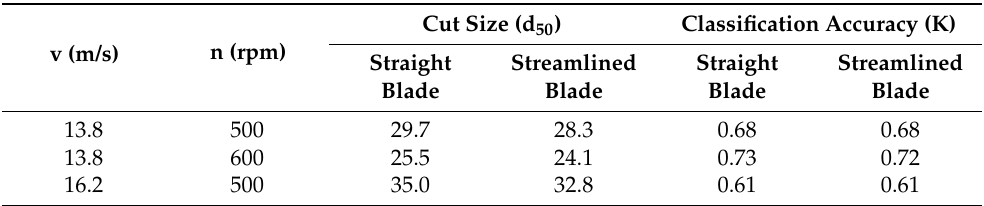
Figure 13. The cloud diagram for the radial velocity distribution and relative velocity streamline corresponding to the streamlined blade. Table 5. The cut size and classification accuracy for the different blade